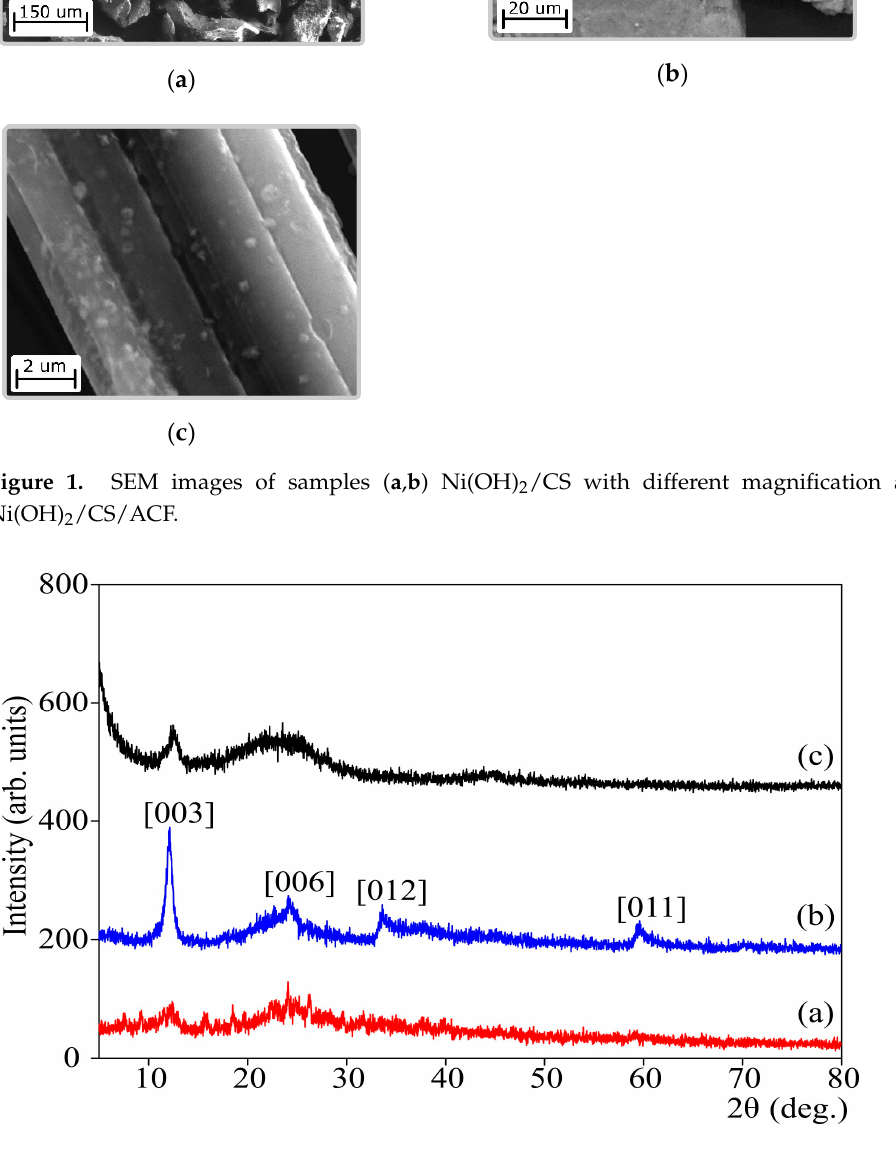
Figure 2. X-ray diffraction patterns of different samples Ni(OH) 2 /CS: ( a ) and ( b ) were obtained in different experiments; ( c ) was obtained in the presence of ACF as a substrate simultaneously with ( b ).